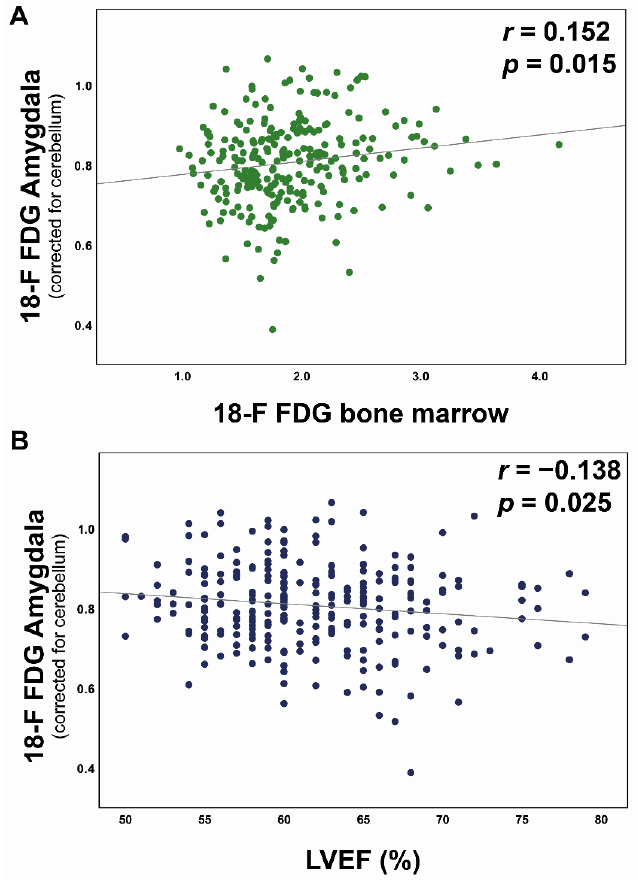
Figure 2. Association of resting amygdala activity with bone marrow metabolism and cardiac function. Pearson product-moment correlation of 18 F-FDG amygdala uptake (standardized uptake value ratio, SUVR) shows a positive correlation with bone marrow activity (standardized uptake value, SUV, ( A )) and a negative association with left ventricular ejection fraction (LVEF, %, ( B )). Correlation coefficients and p -values are indicated. 18 F-FDG, 18 F-fluorodeoxyglucose.